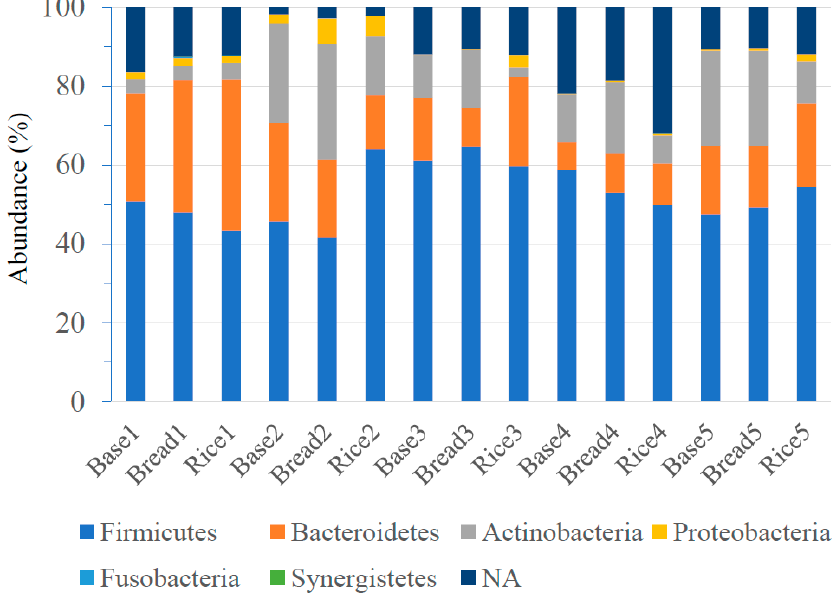
Figure 2. Phylum -level classification of bacteria identified in fecal samples of five subjects. The phyla represented by the different colors are shown below the figure. Baseline: Base; After bread period: Bread; After rice period: Rice.